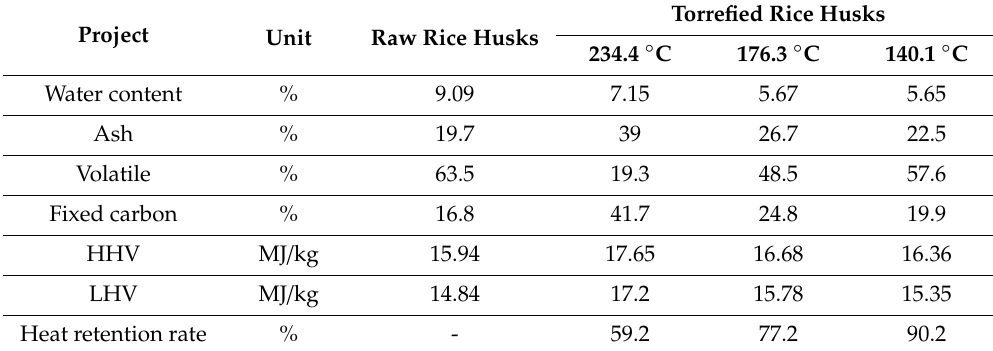
Table 3. Proximate analysis results of torrefied rice husks.